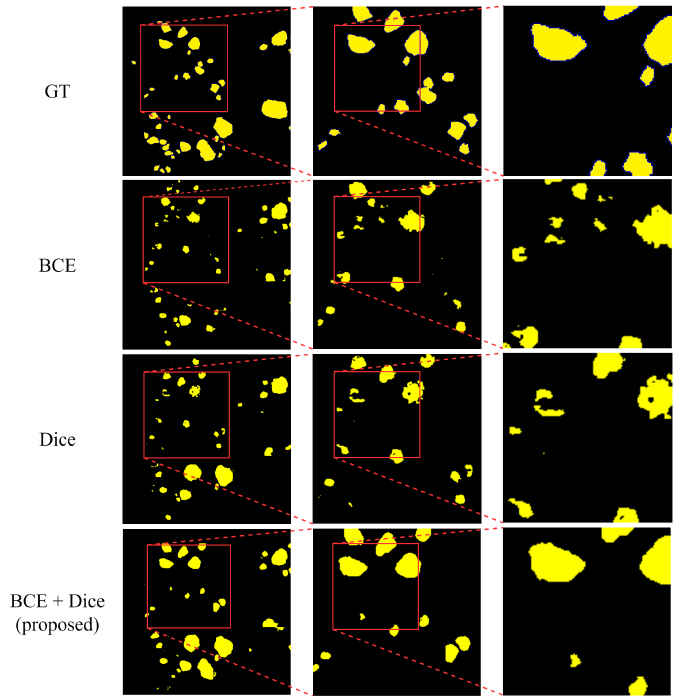
Figure 6. Comparison between the predictions of RUF model trained using BCE, Dice, and BCE + Dice loss. It can be observed that the predictions obtained using BCE + Dice loss have discrete continuous boundaries similar to the ground truth